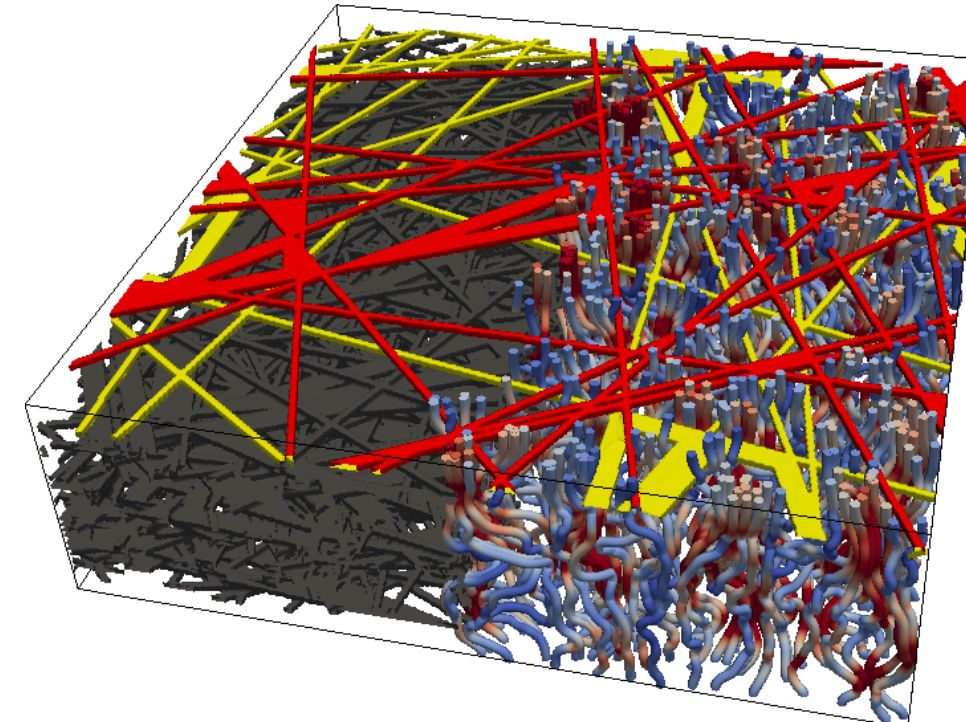
Figure 4. The 3D structure of a micro-structure with b r = 18 µm and through-plane transport simulation [9].